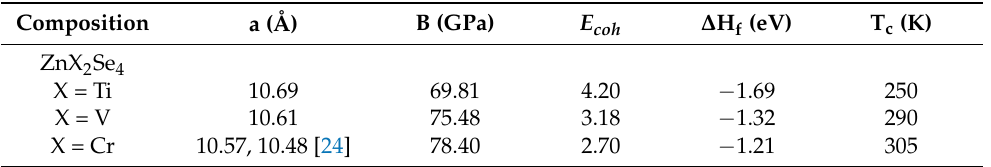
Table 1. The computed a(Å): Lattice constant, B(GPa): Bulk modulus, E coh : Cohesive energy, ∆ H f (eV): Formation energy and T c (K): Curie temperature of ZnX 2 Se 4 (X = Ti, V, Cr).